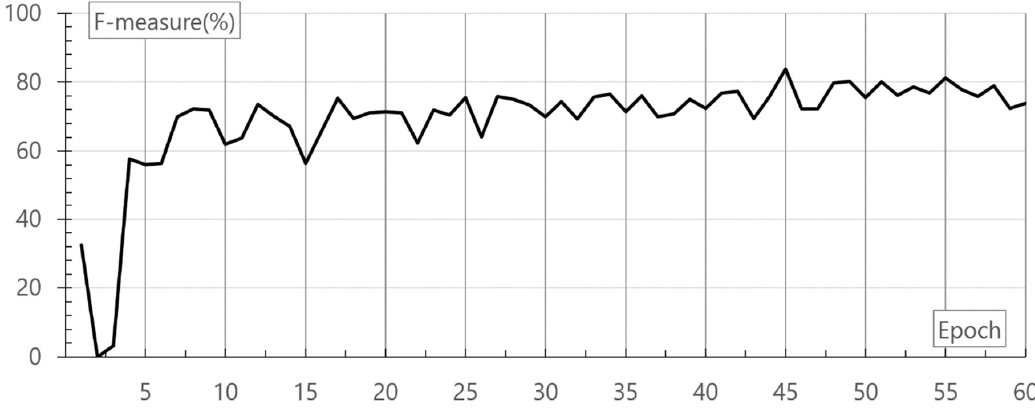
Figure 10. Result of F-measure according to the epoch of deep neural networks.